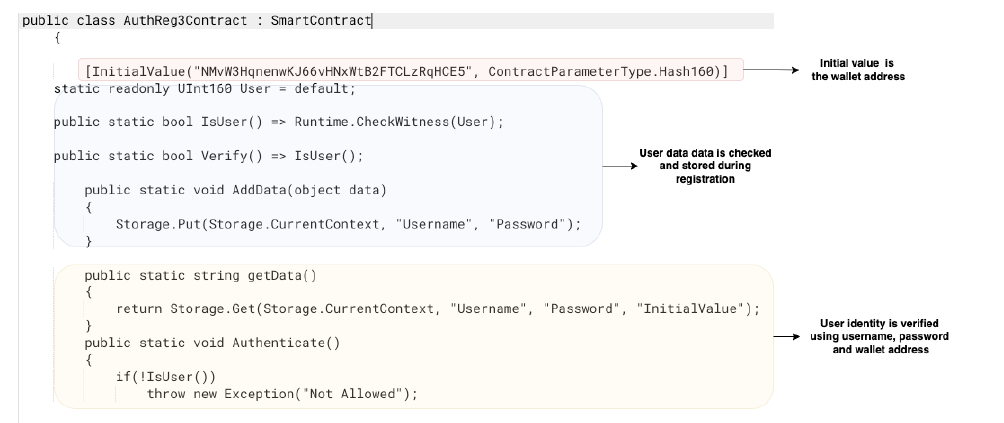
Figure 5. Smart contract for user registration and authentication. Algorithm 2 Pseudocode showing steps to authenticate